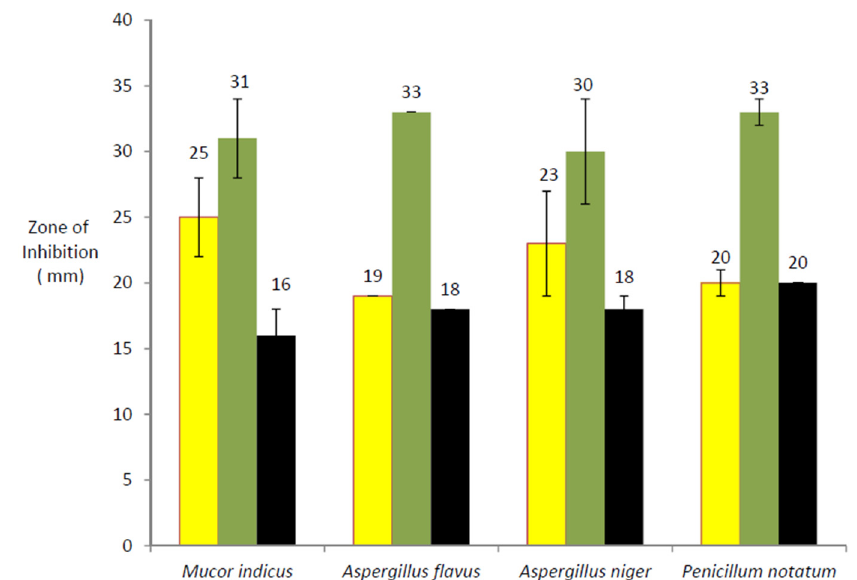
Figure 1. Antifungal activity of methanolic extract against four test fungi: (1) Mucor indicus ; (2) Aspergillus flavus ; (3) Aspergillus niger ; and (4) Penicillum notatum . Antifungal activity within methanolic extracts of leaves (yellow bar), stem (green bar) for A. mexicana extracts, while black bars indicates antifungal activity of Amphoterecin ‐ B. Error bars shown on each histogram indicates standard deviation.